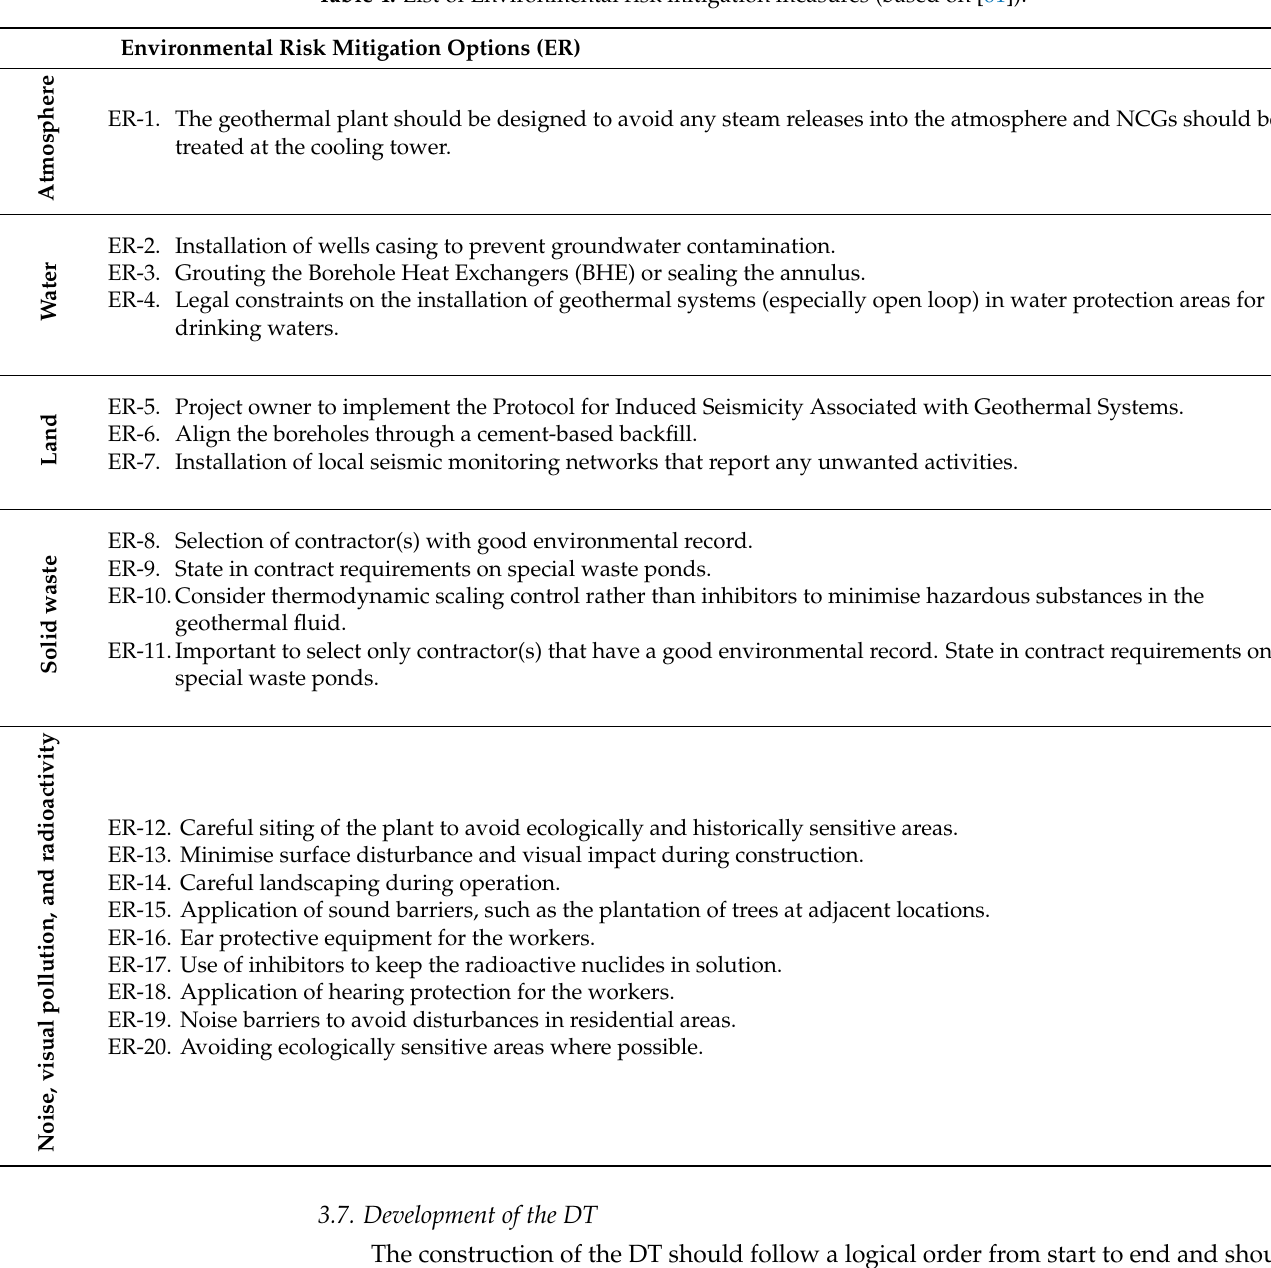
Table 4. List of Environmental risk mitigation measures (based on